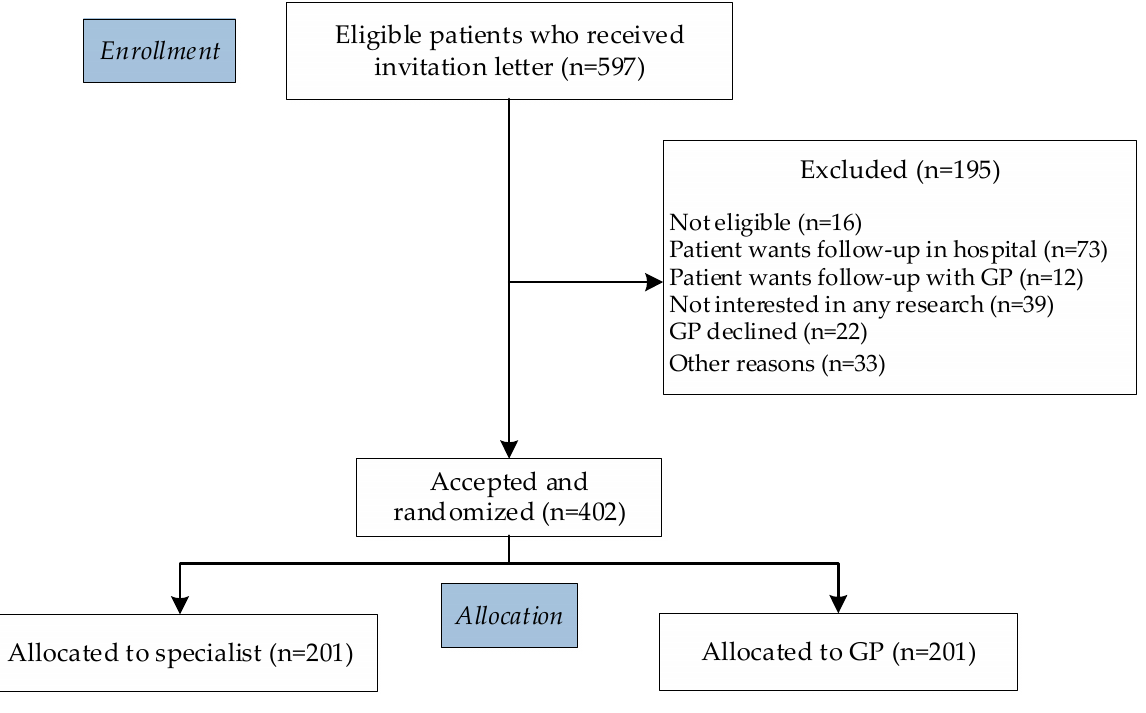
Figure 1. Consort flow diagram.